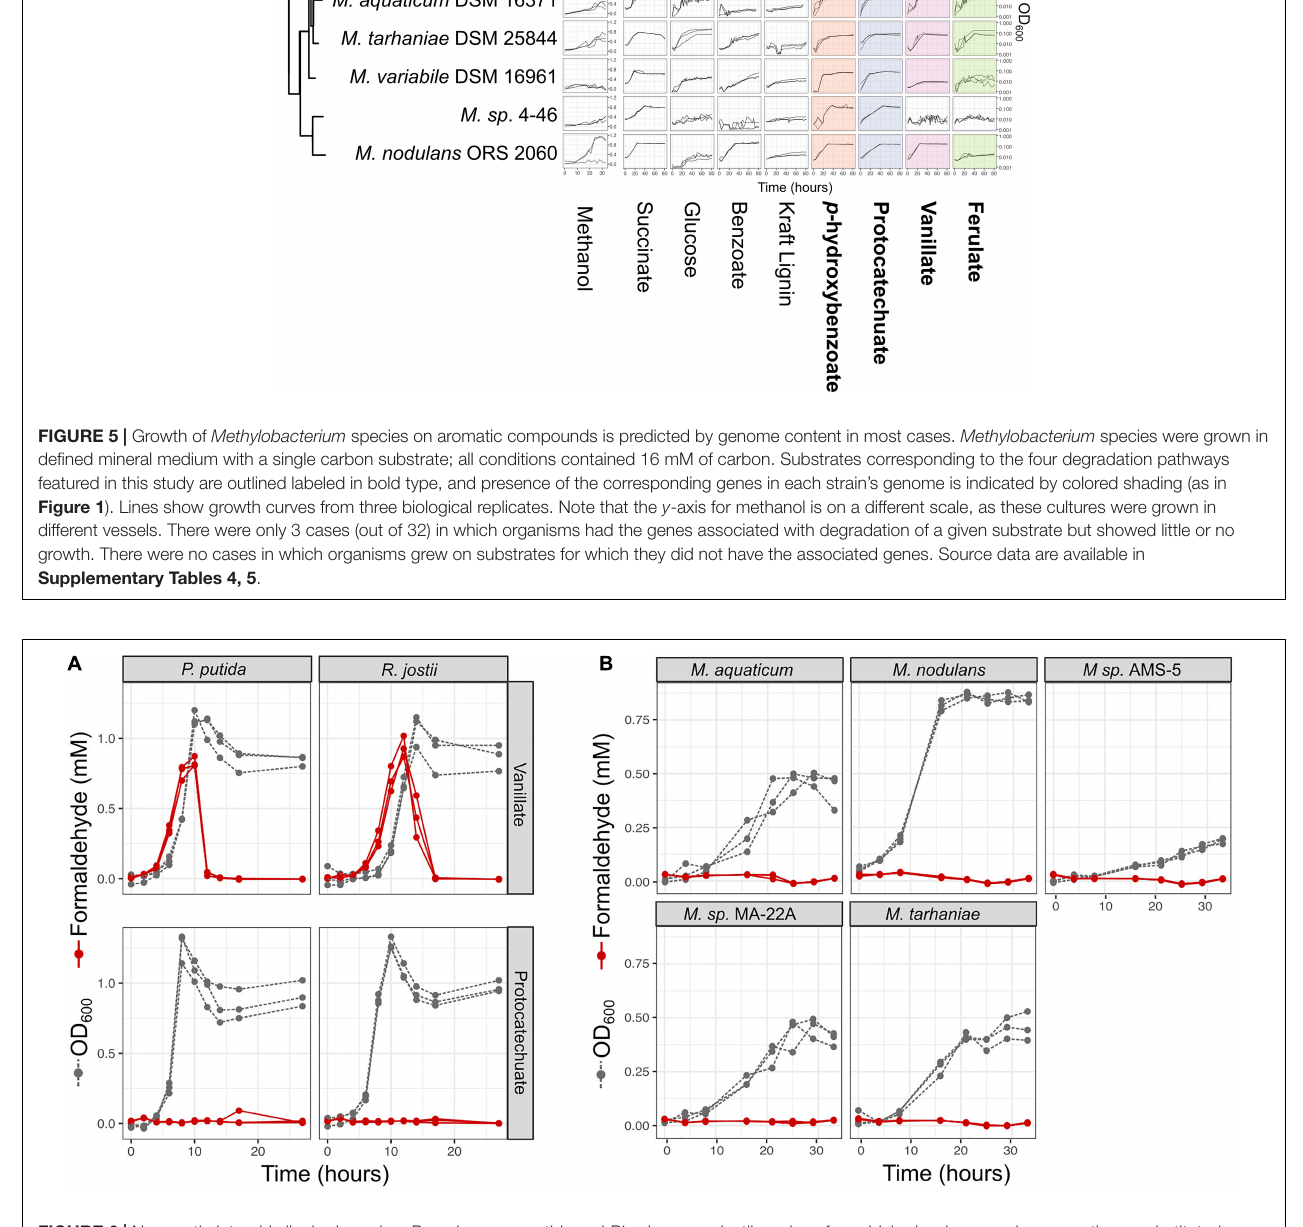
Frontiers in Microbiology |